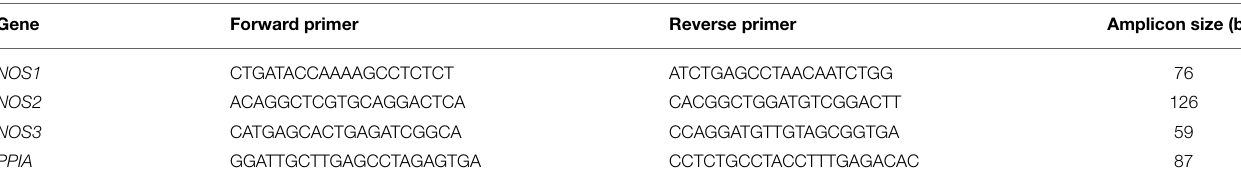
TABLE 1 | Primers used for PCR